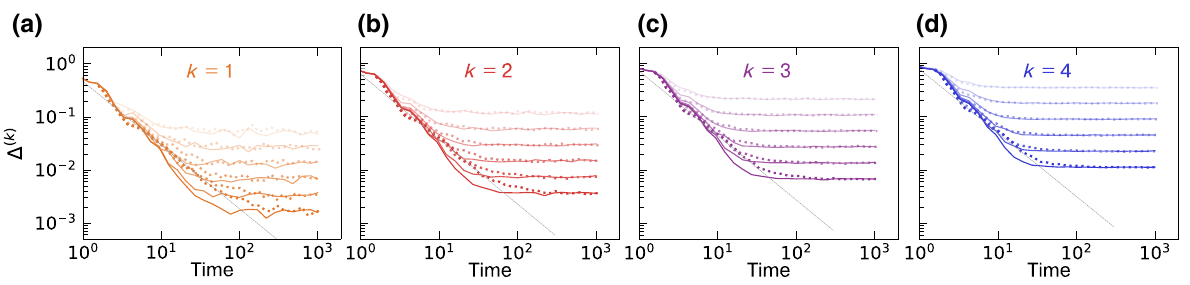
FIG. 6. Emergent quantum state designs in Floquet dynamics. The trace distance (cid:10) ( k ) versus the time for time evolution under the Floquet dynamics in Eq. (C1), for k = 1, 2, 3, 4 in (a), (b), (c), and (d), respectively. We plot the trace distance (cid:10) ( k ) between the k th moments of the Haar ensemble and the projected ensembles for an N A = 3 subsystem and the total system sizes N = 12, 14, . . . , 22 (darker colors denote increasing N ). The solid lines denote the Floquet dynamics, while the dotted lines denote the time-independent dynamics. The dashed line denotes the power-law fit for time-independent dynamics. The Floquet dynamics quickly saturate to their late-time (cid:10) ( k ) value and deviate from power-law behavior. This suggests that the power-law decay of (cid:10) ( k ) is associated with hydrodynamic behavior due to energy